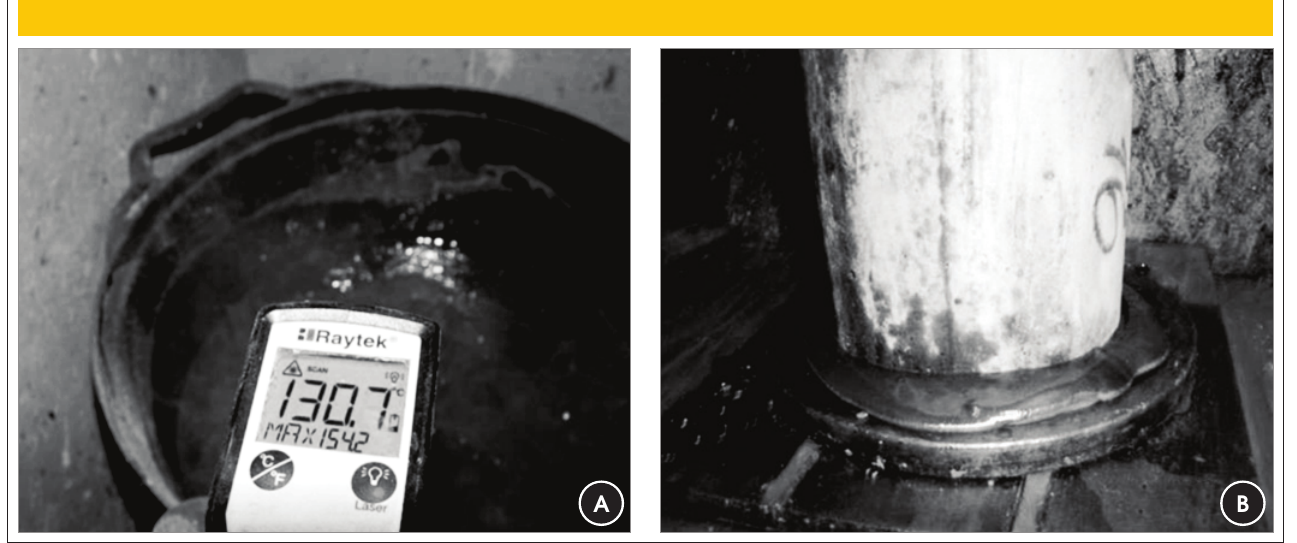
Figure 3 – Temperature of the sulfur mixture (A) (left) and capping of test specimen